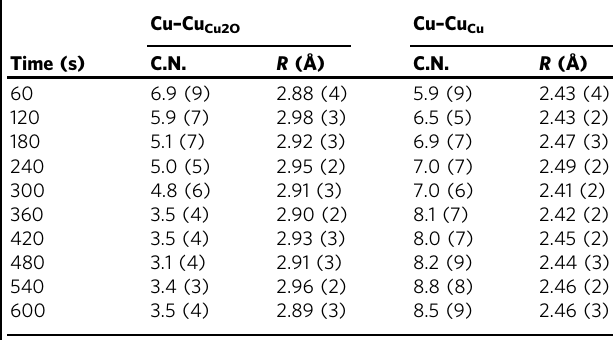
Table 2 Operando EXAFS fi tting parameters for the CuO x at